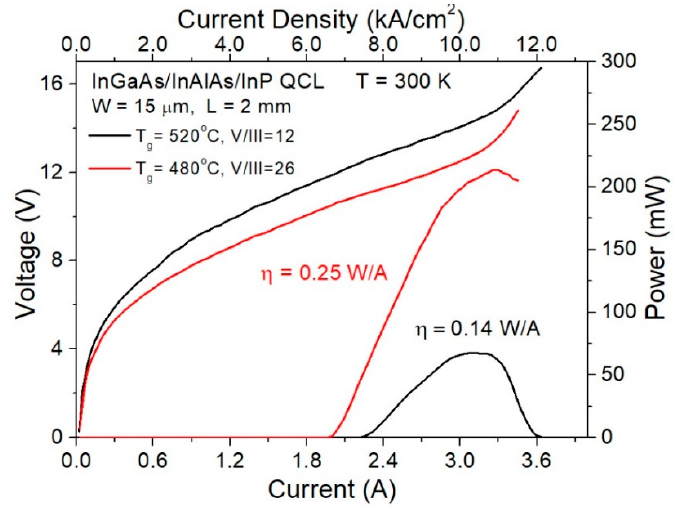
Figure11. Theroomtemperaturelight-currentandvoltage-currentcharacteristicsoftwolattice-matched Figure 11. T he room temperature light-current and voltage-current characteristics of two lattice- In 0.53 Ga 0.47 As / In 0.52 Al 0.48 As / InP lasers; the one grown according to optimized growth technology and matched In 0.53 Ga 0.47 As/In 0.52 Al 0.48 As/InP lasers; the one grown according to optimized growth another grown at constant temperature T g = 520 ◦ C and BEP ratio V / III = technology and another grown at constant temperature T g = 520 °C and BEP ratio V/III = 12.